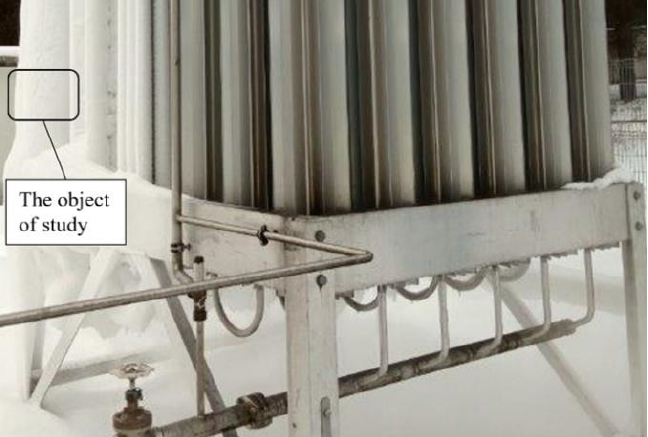
Figure 2. Finned tubes of LNG ambient air vaporizer totally covered by frost.